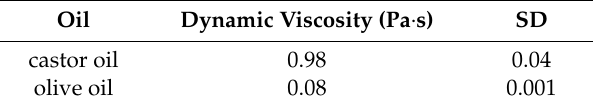
Table 2. Mean viscosity measurements of the selected oils and their standard deviations (SD) at room temperature.